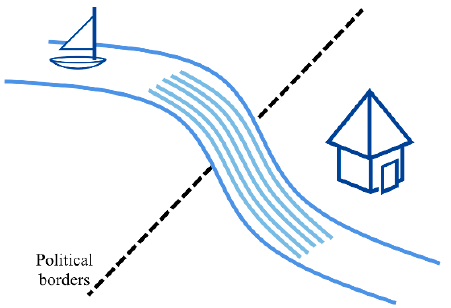
Figure 1. Particles of water, a river, flowing through a political border.